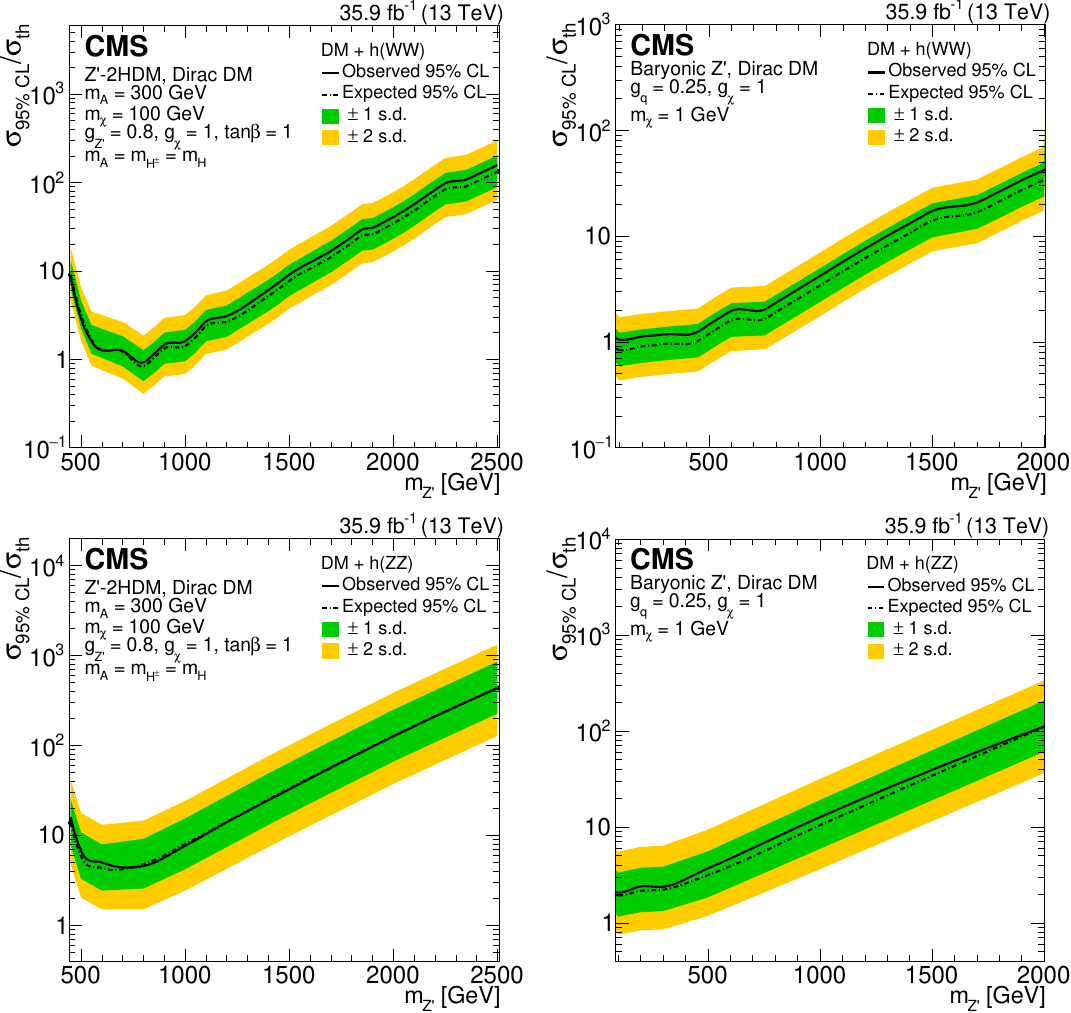
Figure 7 . The upper limits at 95% CL on the observed and expected DM production cross section for the h WW (upper) and h ZZ (lower) analyses for the Z 0 -2HDM with m ! ! and for the baryonic Z 0 with m = 1 GeV (right) model. The inner and outer shaded bands show (cid:31) the 68 and 95% uncertainties in the expected limit,